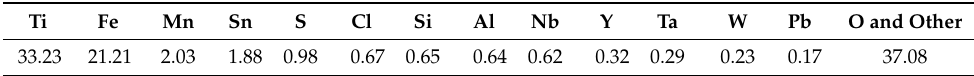
Table 2. Coal proximate analysis (in wt%).